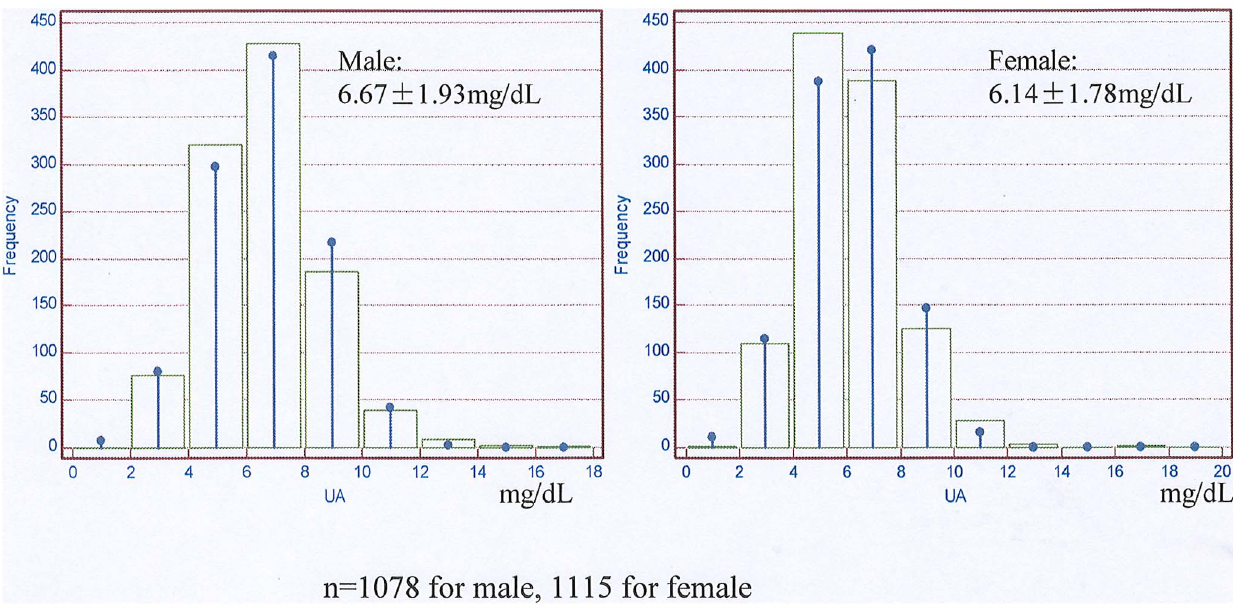
Figure 1. The distribution chart of serum uric acid.